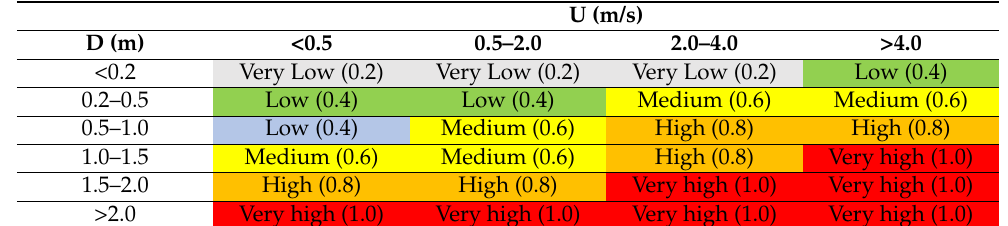
Table 3. Flood hazard